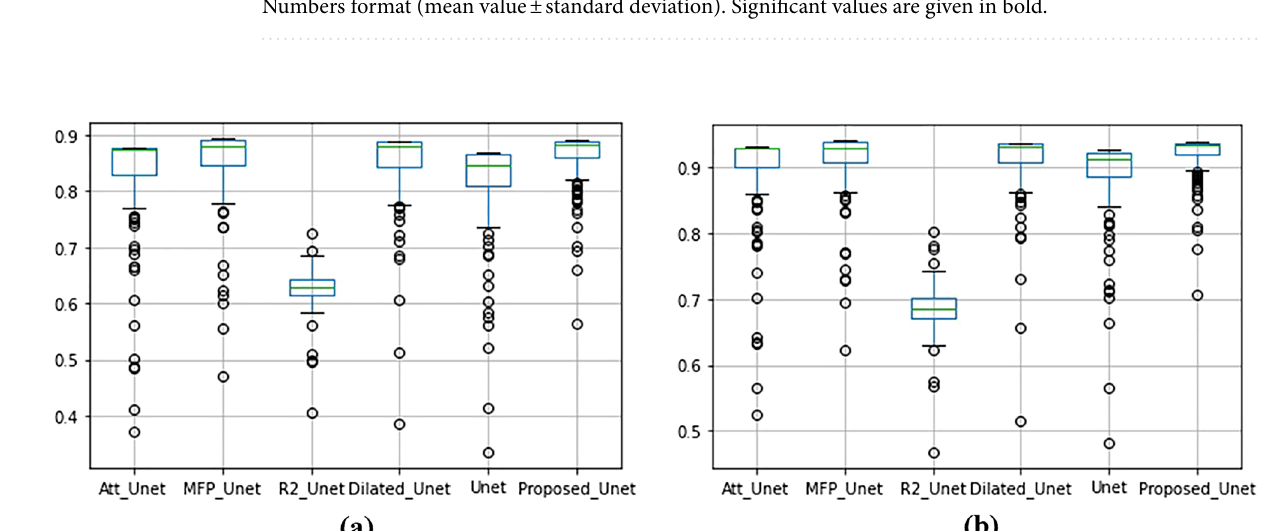
Table 2. Comparison of test results for CRL and Foot segmentation from CRL and Foot-MFP dataset Numbers format (mean value ± standard deviation). Significant values are given in bold.